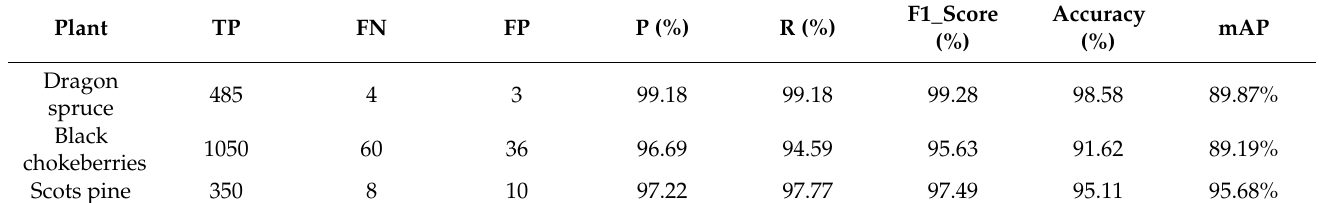
Table 5. The detection results of the model after augmentation.